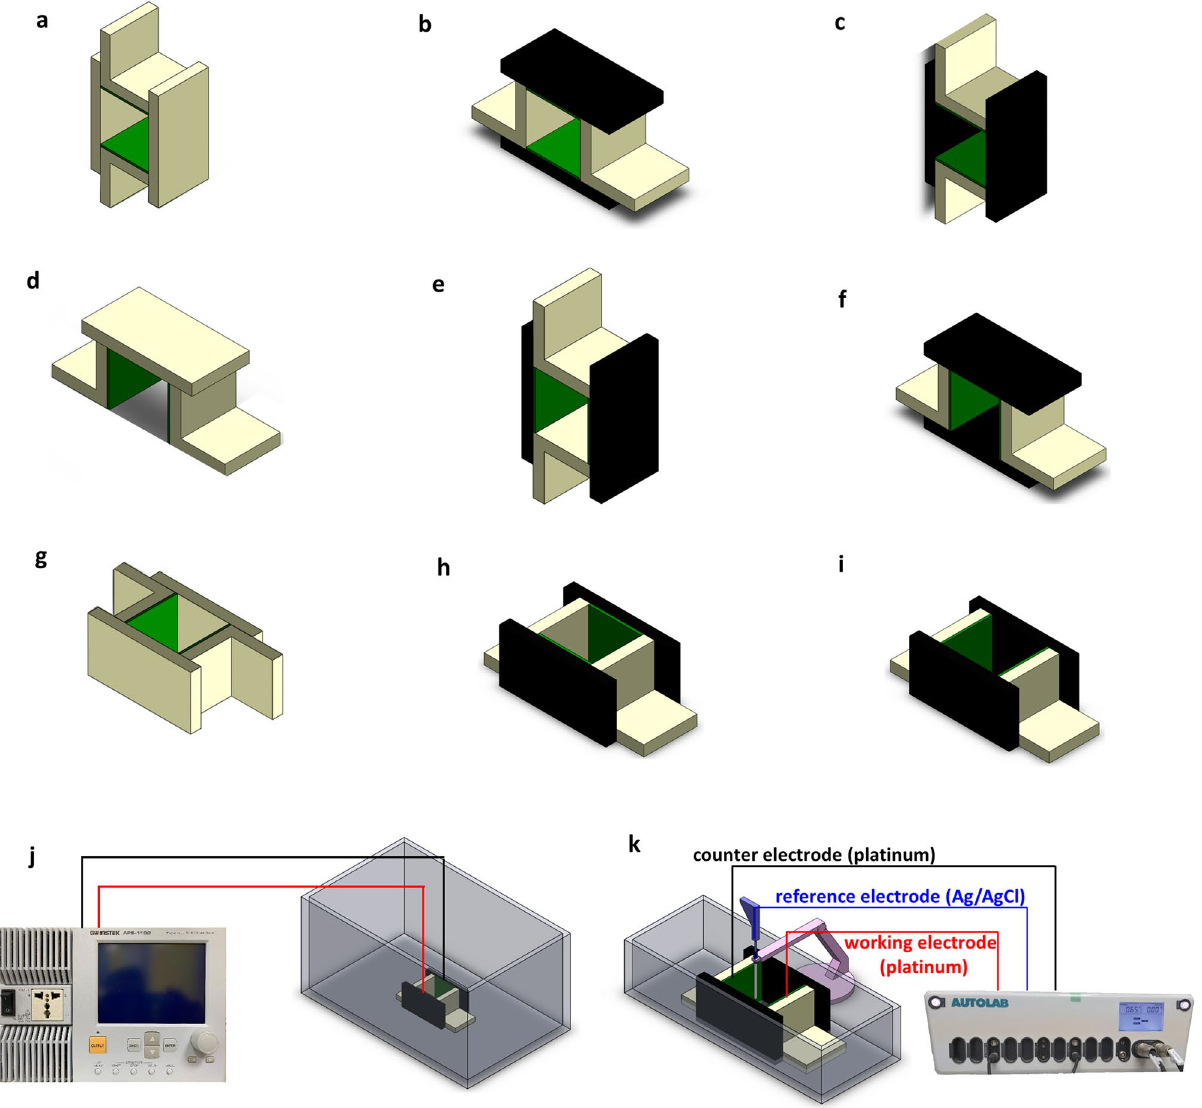
Figure 1. A schematic diagram of the experimental setup and the layout of the electrodes and the magnetic field. The black area is a pair of N35 magnets (100 mm long, 50 mm wide, and 10 mm high) whose surface field strength is nearly 0.22 T, the green part is the electrodes (50 mm long and 50 mm wide) and the yellow part is the isolating plastic that is used to form the duct. Various magnetic field configurations were used to determine the effect of the field on the behaviors of the gas bubbles: ( a ) electrodes placed horizontally without a magnetic field. ( b ) Electrodes placed horizontally with two horizontal magnets. ( c ) Electrodes placed horizontally and perpendicular to the magnets to create a Lorentz force (denoted as F L ) in the horizontal direction. ( d ) Electrodes placed vertically without a magnetic field. ( e ) Electrodes placed vertically with vertical magnets. ( f ) Electrodes placed vertically and perpendicular to magnets to create a Lorentz force in the horizontal direction. ( g ) Electrodes placed vertically without a magnetic field and with an upward exit. ( h ) Electrodes placed vertically with vertical magnets and an upward exit. ( i ) Electrodes placed vertically and perpendicular to the magnets to create a Lorentz force in the vertical direction and with an upward exit. ( j ) All the experiments were conducted in a 40 cm long, 24 cm wide, and 20 cm high water tank. The electrodes were connected to a power supply (GWInstek APS-1102) that generates a maximum current of 10 A. ( k ) Schematic diagram of a three-electrode cell for the potentiometry high water tank, as shown in Fig. 1j. The electrodes were connected to a power supply (GWInstek APS-1102) that generates a maximum current of 10 A. To further investigate action mechanism of magnetic field on gas bubbles movement, electrochemical measurements were carried out using a potentiostat (AutoLab PGSTAT302N) in a three-electrode cell configuration, as shown in Fig. 1k. All the electrochemical measurements were carried out at room temperature. Potentiometry scan curves were measured for the current density of 200 A/cm 2 at constant scan rate of 10 mV/s. The platinum sheets were used as a working electrode (WE) and a counter electrode (CE).